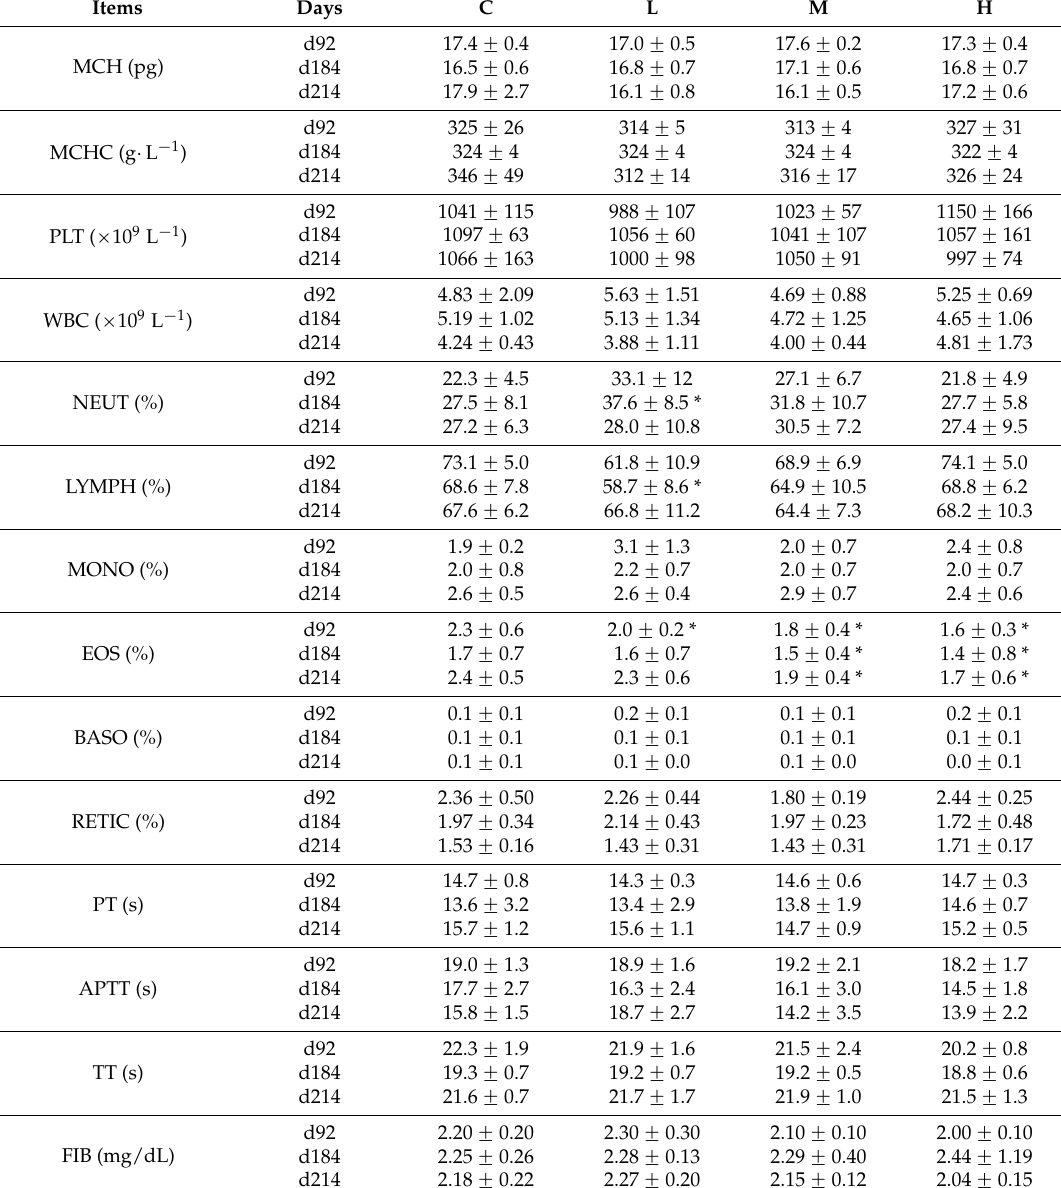
– x ˘ SD, d92 n = 5, d184 n = 10, d214 n =